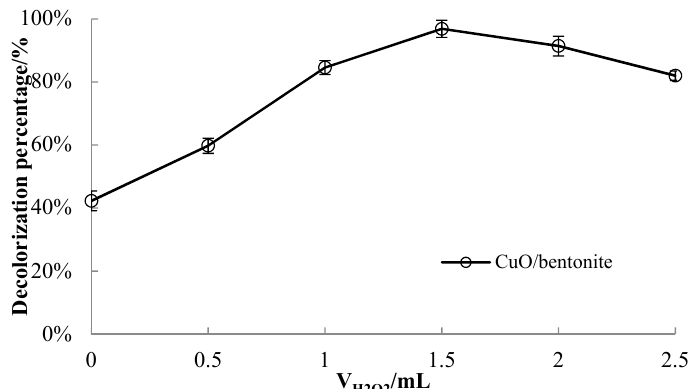
Figure 3. Effect of H 2 O 2 dosage on decolorization efficiency of the MB solution.